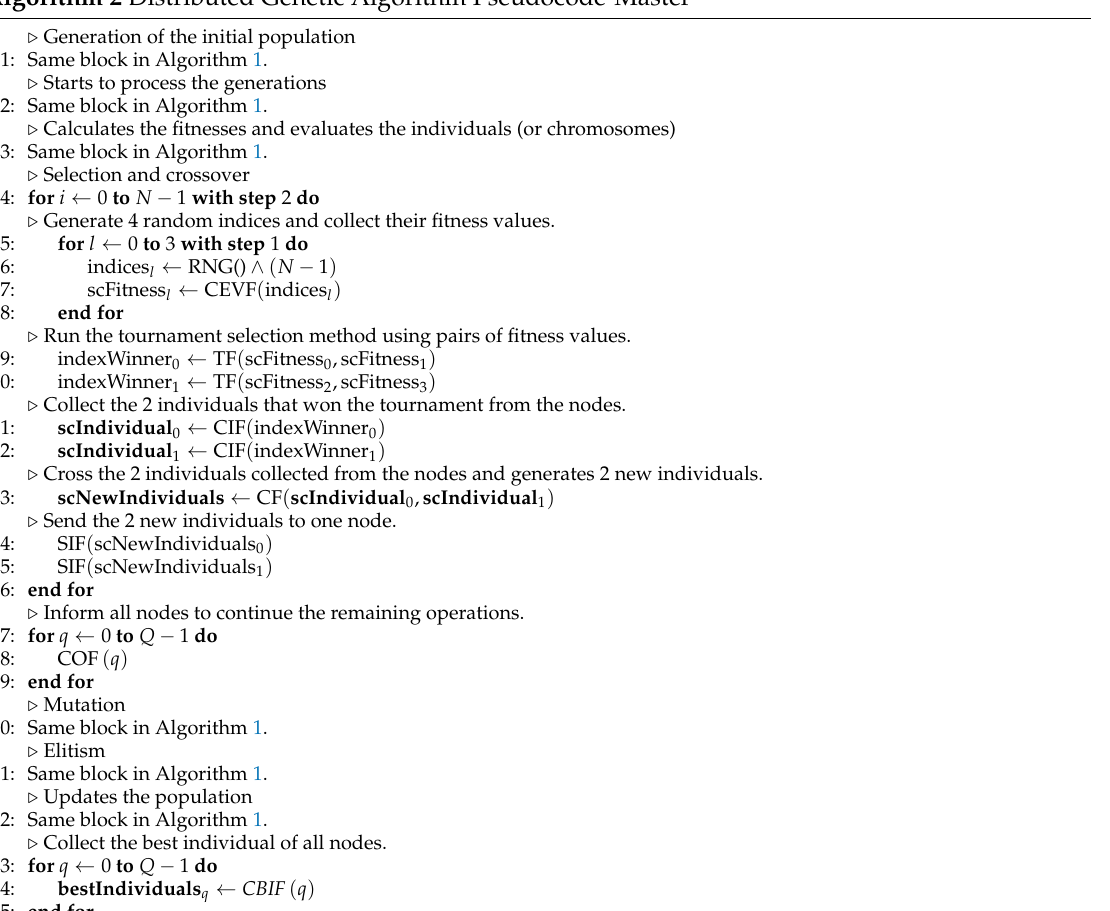
Algorithm 2 Distributed Genetic Algorithm